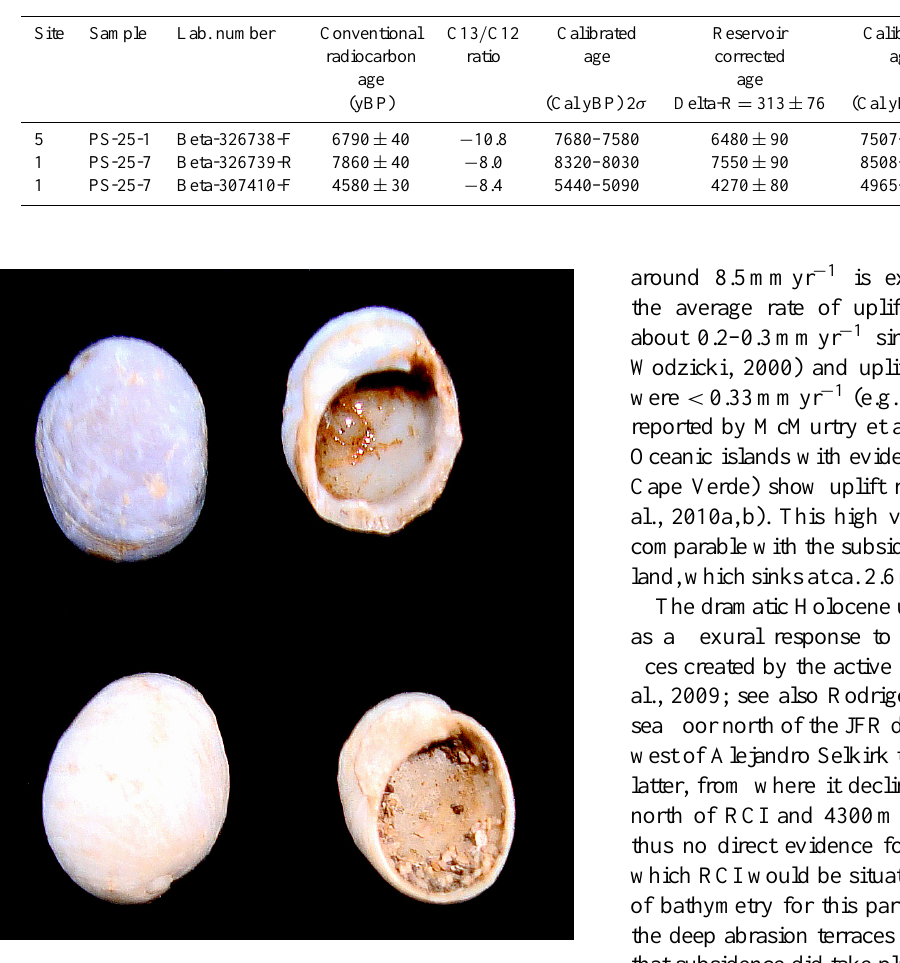
Figure 3. Nerita shells found in aeolian deposits of unit 2. These are marine species, probably incorporated into dunes developed close to the supratidal flat shoreline. Visual field is